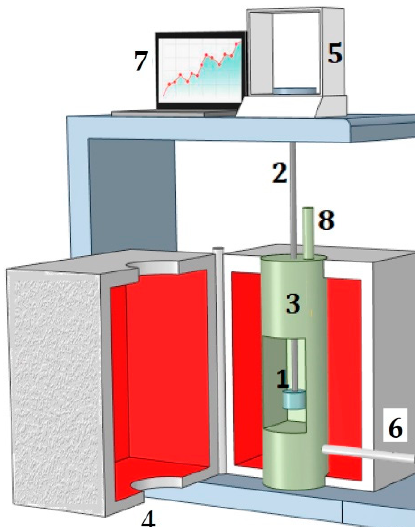
Figure 2. Drying apparatus. 1—crucible; 2—metal wire; 3—internal tube; 4—heater; 5—electronic